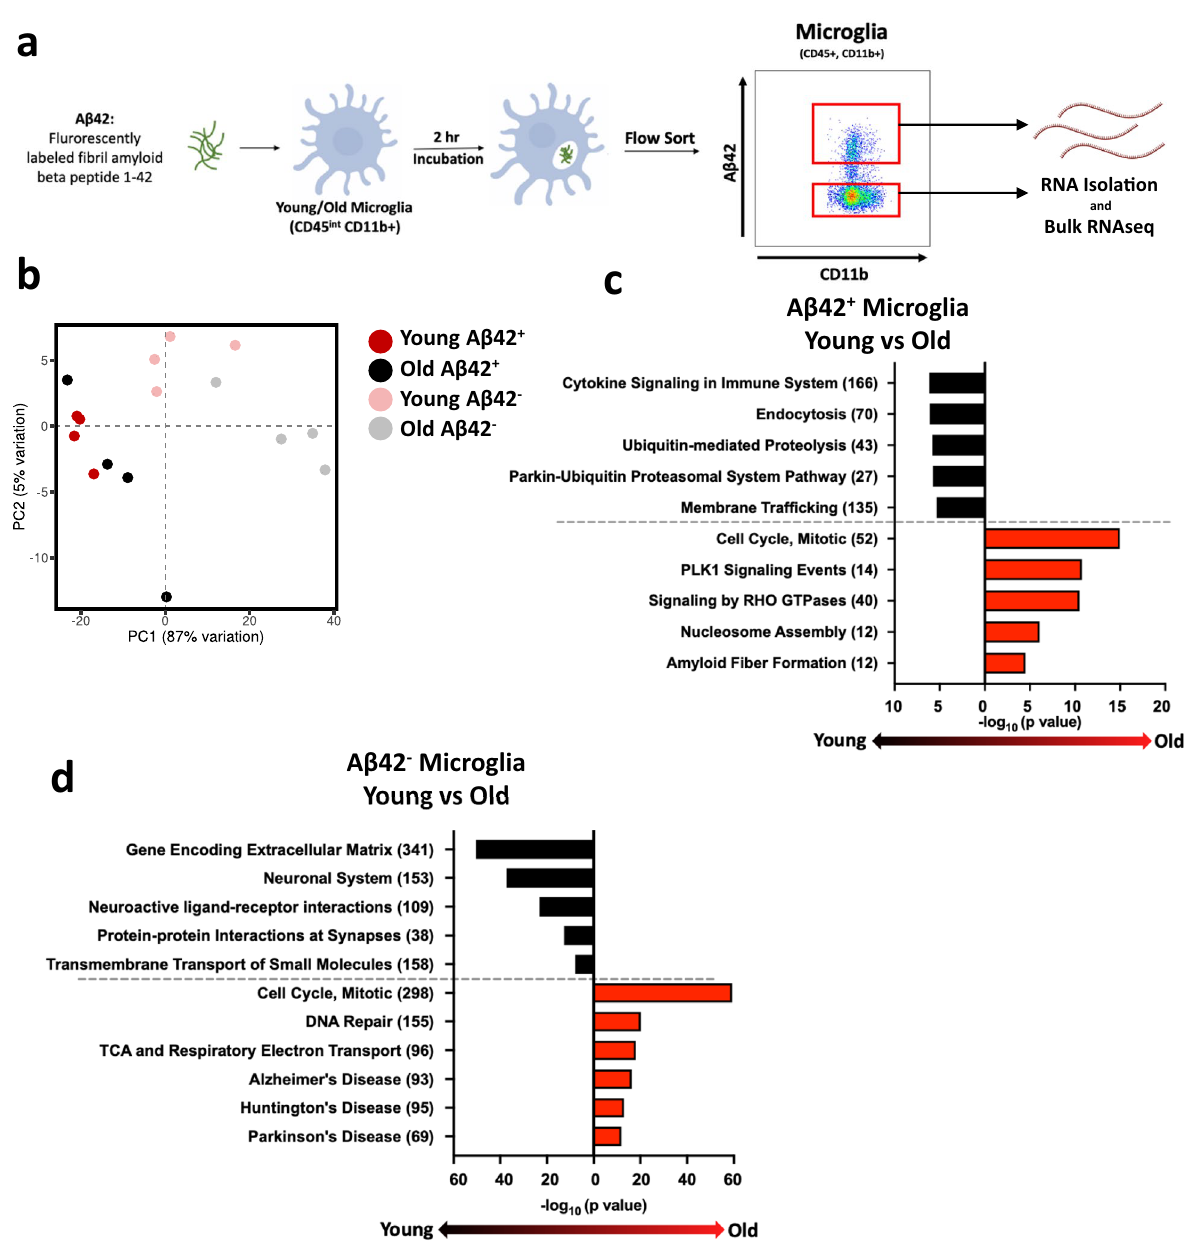
Figure 3. Pathway analysis of young and old microglia that either did or did not take up peptide showed deficiencies of old microglia. Young (2 months) and old (18 months) microglia (3 male mice were combined to make one replicate; this was repeated for a total of 4 replicates/group) were incubated with 2.5 μM of Aβ42 for 2 h and then were FACSorted based on Aβ42 uptake. Sorted microglia’s RNA was isolated and used to run bulk RNAseq analysis. ( a ) Schematic of phagocytosis assay and flow sorting, images made using ©BioRender - biorender.com. ( b ) Principal component analysis plot of the four different microglia groups (Young Aβ42 + , Young Aβ42 − , Old Aβ42 + , Old Aβ42 − ) with 4 replicates each. Pathway analysis of DEGs in both the young and old ( c ) Aβ42 + and ( d ) Aβ42 − microglia graphed based on their p value. The number of DEGs in each pathway are indicated in